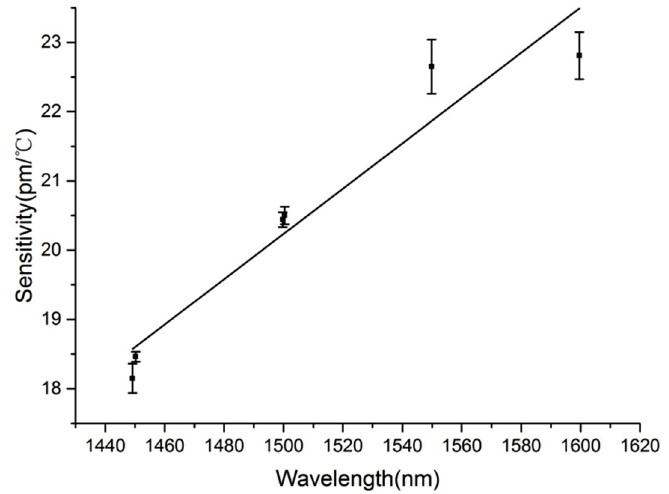
Figure 10. The dependence of sensitivity on probing wavelength. The error bars show the differences between experimental and fitting